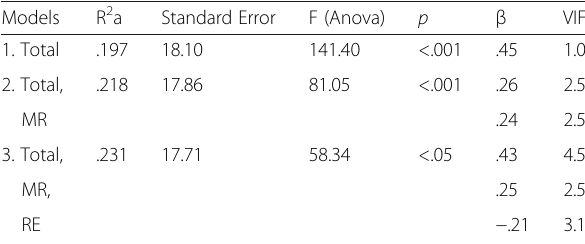
Table 5 Stepwise regression analysis models for TLN-C Models